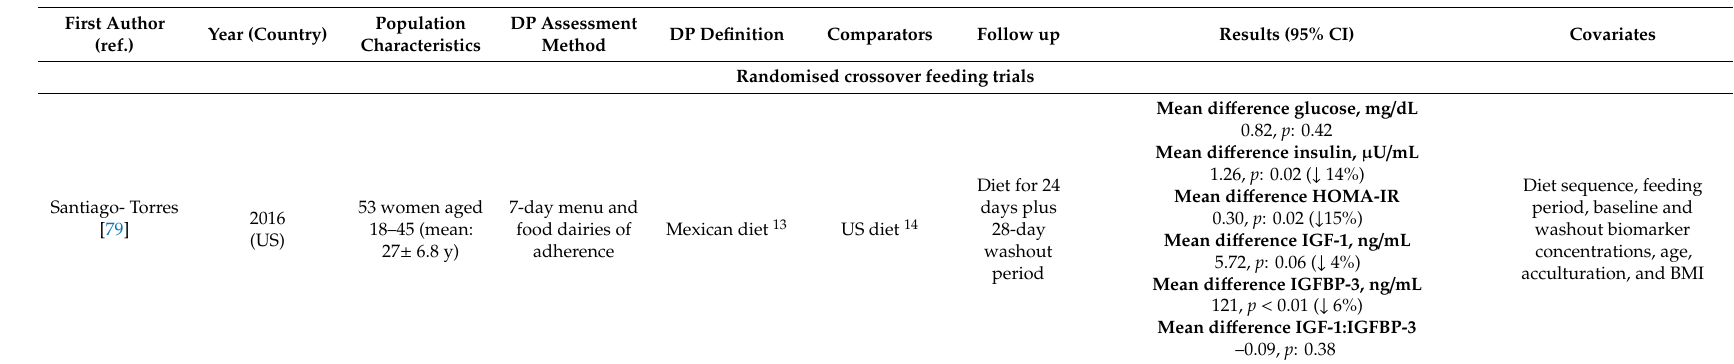
The following underlined descriptions refer to descriptions of Mexican diets. 1: Mexican cheeses, soups, meat dishes, legumes, tomato-based sauces. 2: Tortillas and tacos flavoured and sweetened drinks, legumes, red meat, eggs, cakes and cookies, milk, non-citrus fruits. 3: Poultry, flavoured and sweetened drinks, alcoholic beverages, bread and wheat products, cakes and cookies. 4: Flavoured and sweetened drinks, cakes and cookies, milk, tortillas and tacos, pizza, bread and wheat products, and soups. 5: Red meat, flavoured and sweetened drinks, tortillas and tacos, and bread and wheat products. 6: Maize tortillas and maize-based foods, alcohol, Mexican snacks, sugar-sweetened beverages, and white bread and wheat tortillas. 7: Maize tortillas, maize-based foods, alcohol, sugar-sweetened beverages, white bread and wheat tortillas, Mexican snacks, dairy products, sweet bread, cookies, fast food, and red meat. 8: Maize tortillas, maize-based foods, whole-fat dairy products, alcohol, SSBs, white bread and wheat tortillas, fresh fruit, Mexican snacks, rice and pasta, high fibre, ready-to-eat cereal, and sweet bread. 9: Fish and seafood, low-fat cereals, fruits and vegetables. 10: Meat, chicken, desserts, and processed meat. 11: Beverages, legumes, tortilla s . 12: High in tortillas, beans, soups, Mexican dishes, fruits, vegetables, rice, full-fat milk and cheeses. Low in oil, solid fat, sugar, processed meats, and refined grains. 13: Beans, corn tortillas , traditional Mexican soups and Mexican mixed dishes, citrus fruits, vegetables, animal fats, full-fat milk, and aguas frescas (water blended with fruits). 14: Refined grains, vegetable oils, non- or low-fat milk, processed foods, processed meats, sugar-sweetened beverages, and grain-based desserts. BMI: Body mass index. CI: Confidence intervals. DP: Dietary pattern. FFQ: